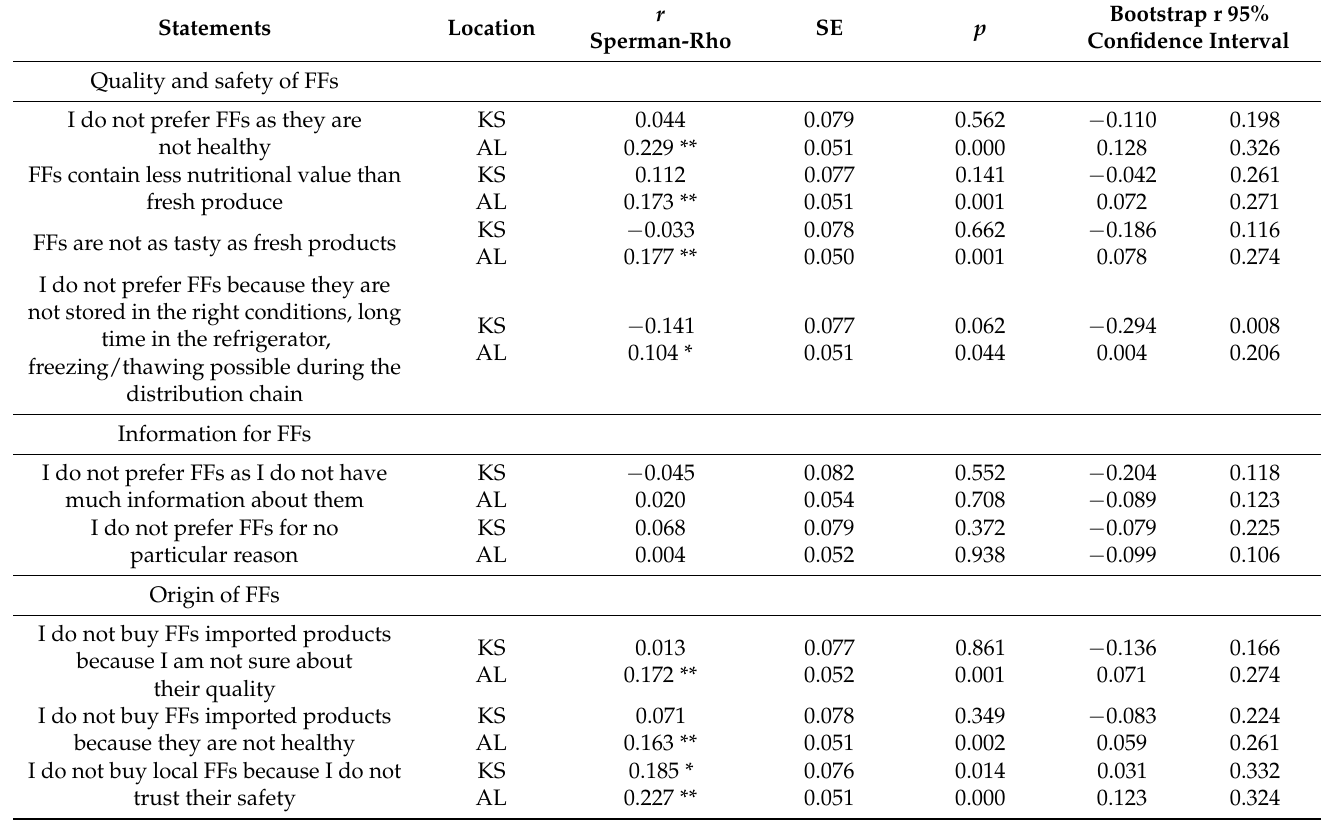
Table 4. Correlation coefficients between age and consumers’ perception for frozen foods in Kosovo and